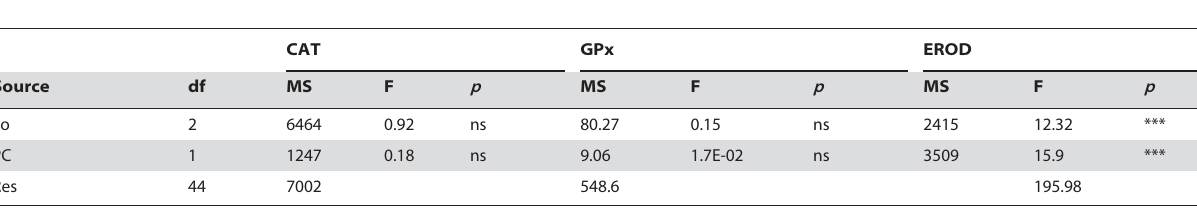
Table 4. PERMANOVA testing differences in two antioxidant biomarkers (CAT and GPx) and activity of EROD of fish population among locations and between invaded (TG and BR) vs . non-invaded locations